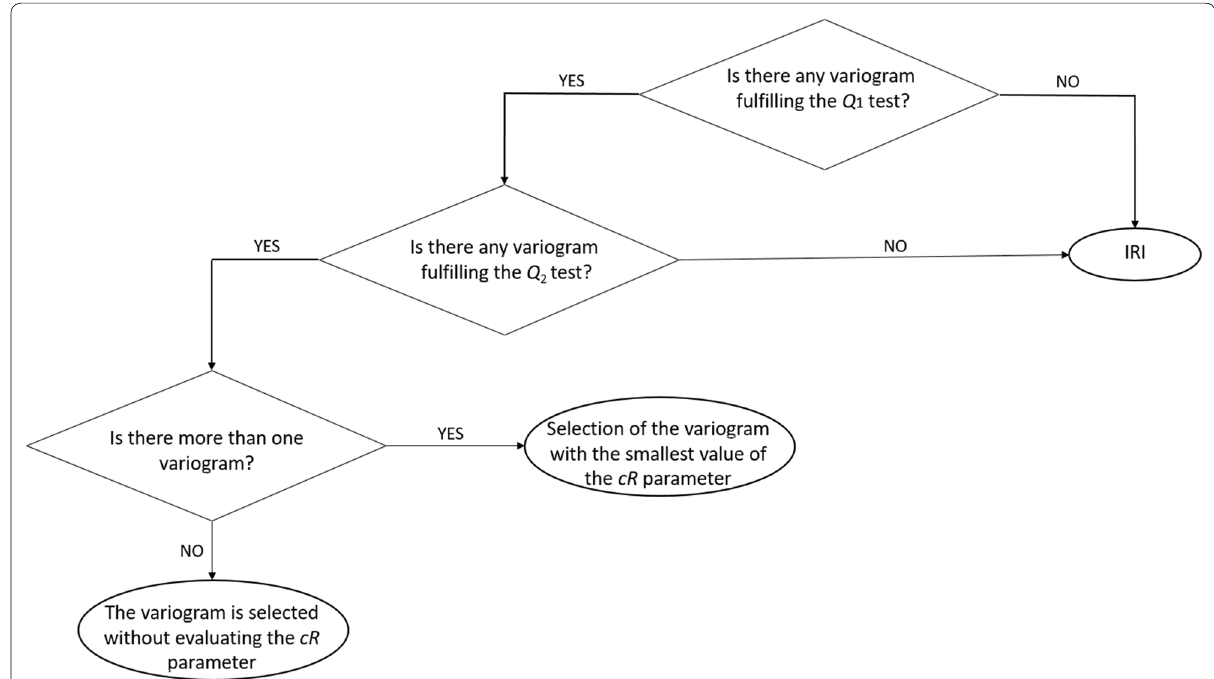
Fig. 6 NQCR procedure flowchart. Flowchart representing the main steps of the NQCR